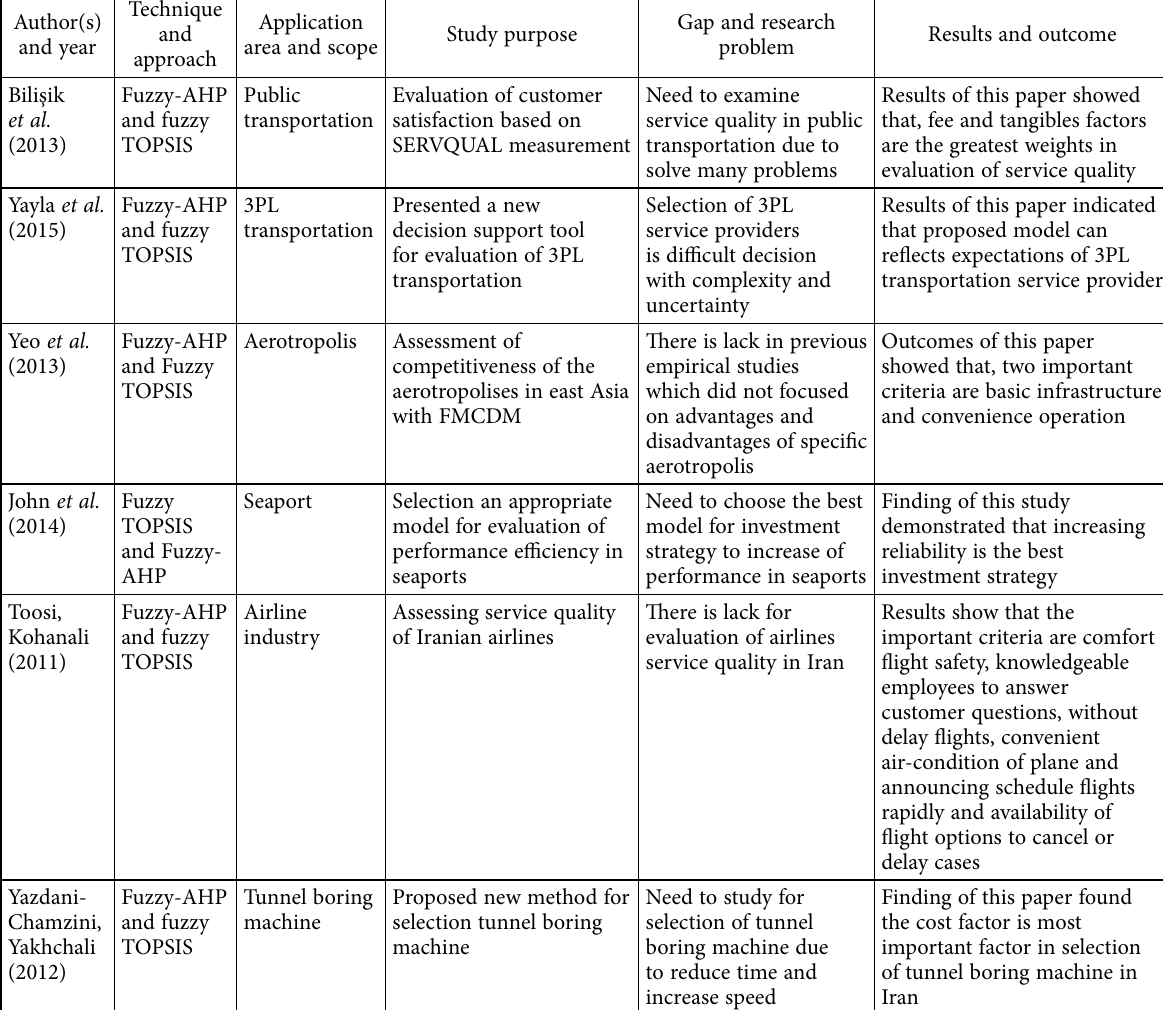
Table 9. Distribution based on integrated AHP, TOPSIS and fuzzy set